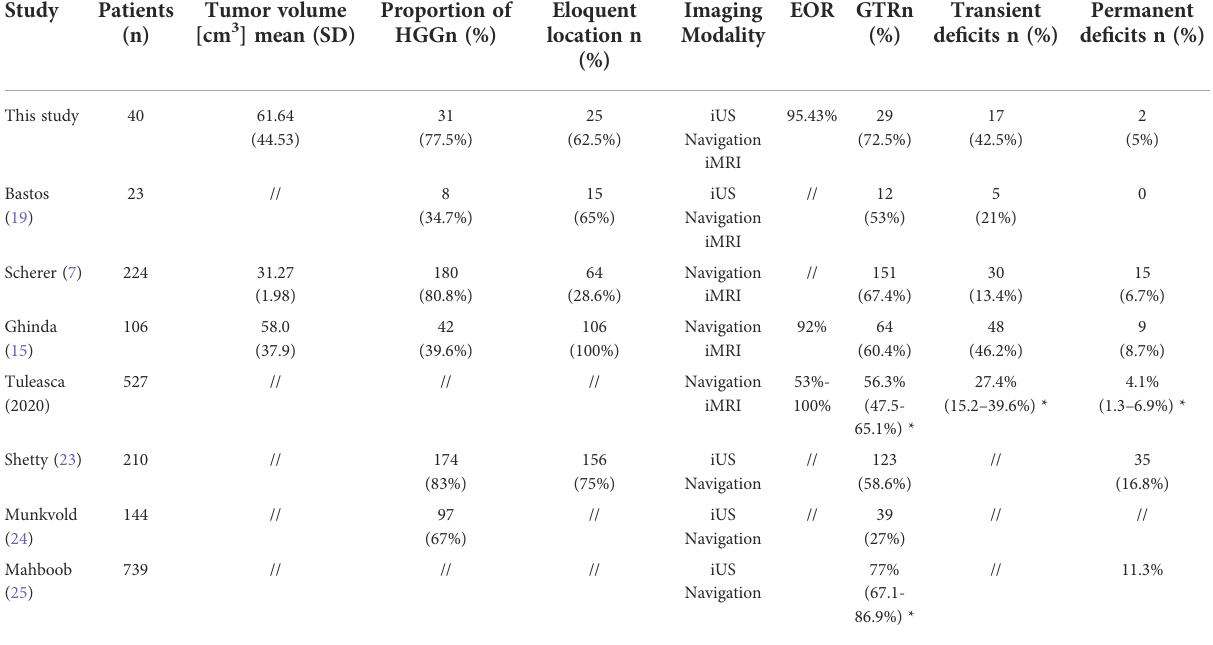
TABLE 3 Surgical results of the typical studies.